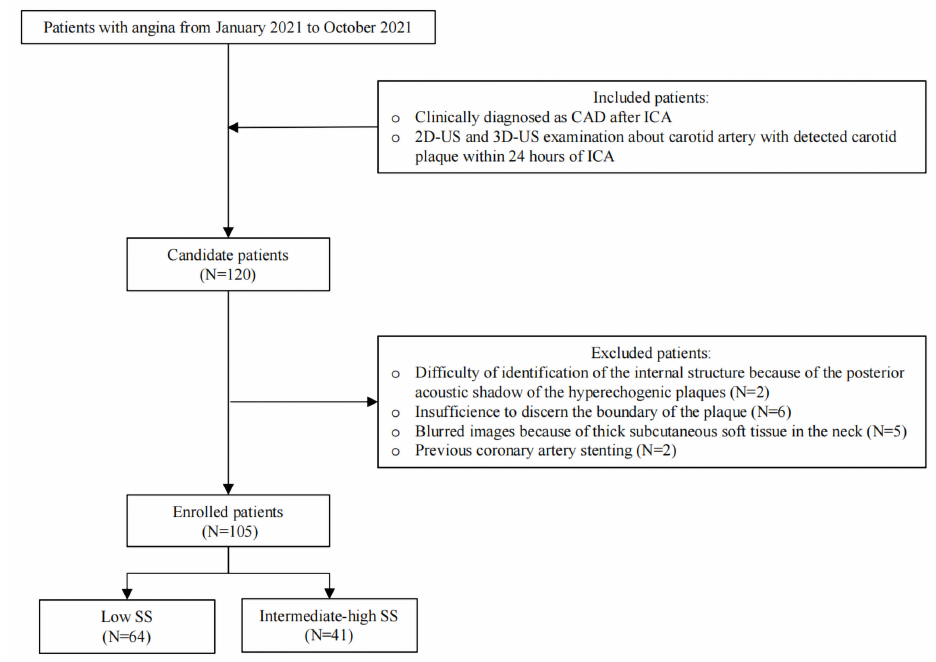
Figure 1. Flow chart of patient enrollment. CAD, coronary artery disease; ICA, invasive coronary angiography; 2D-US, two-dimensional ultrasound; 3D-US, three-dimensional ultrasound; SS, SYNTAX score.